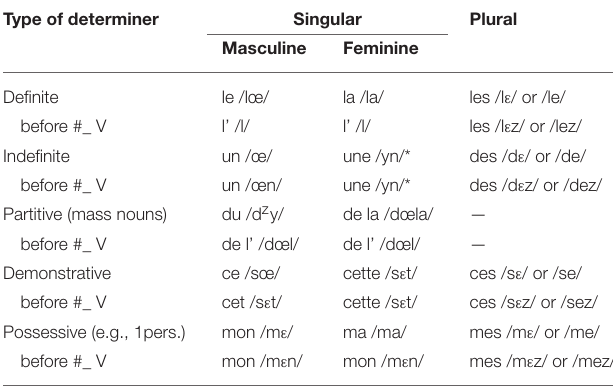
TABLE 1 | A subset of the French determiner system. Type of determiner